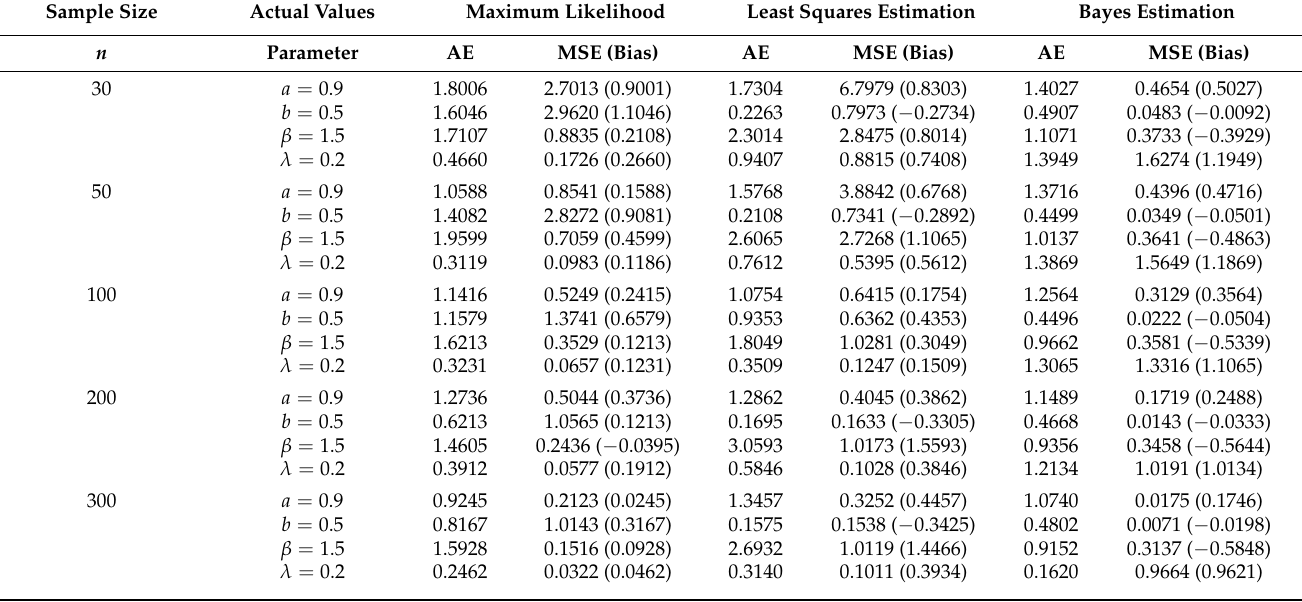
Table 4. Simulation results for the MLEs, SLEs, and BEs based on the NEKwE